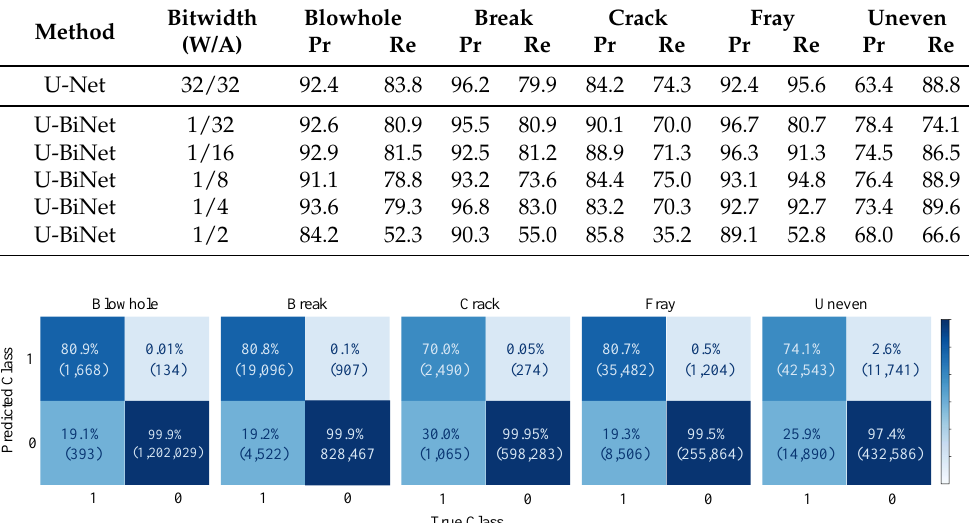
Figure 5. Confusion matrix of U-BiNet on the test set of Magnetic Tile. The figure is best viewed in color and zoomed